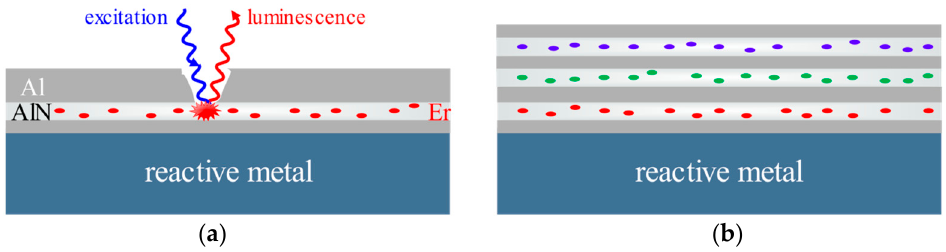
Figure 1. ( a ) Concept of luminescence sensing via erbium doped aluminum nitride (AlN:Er) film; ( b ) multiple luminescent layers, doped with rare-earth ions emitting at different wavelengths, could be inserted into the surface protective coating to evaluate the extent of failure.